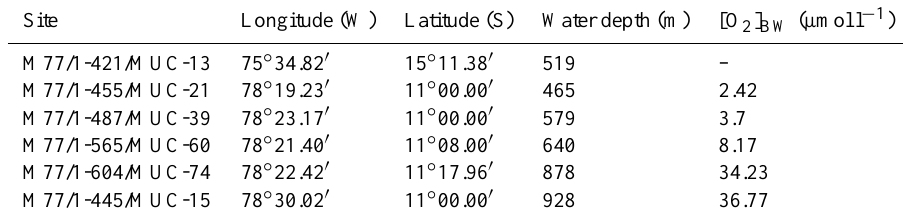
Table 1. Sampling sites. [O 2 ] BW taken from Glock et al.